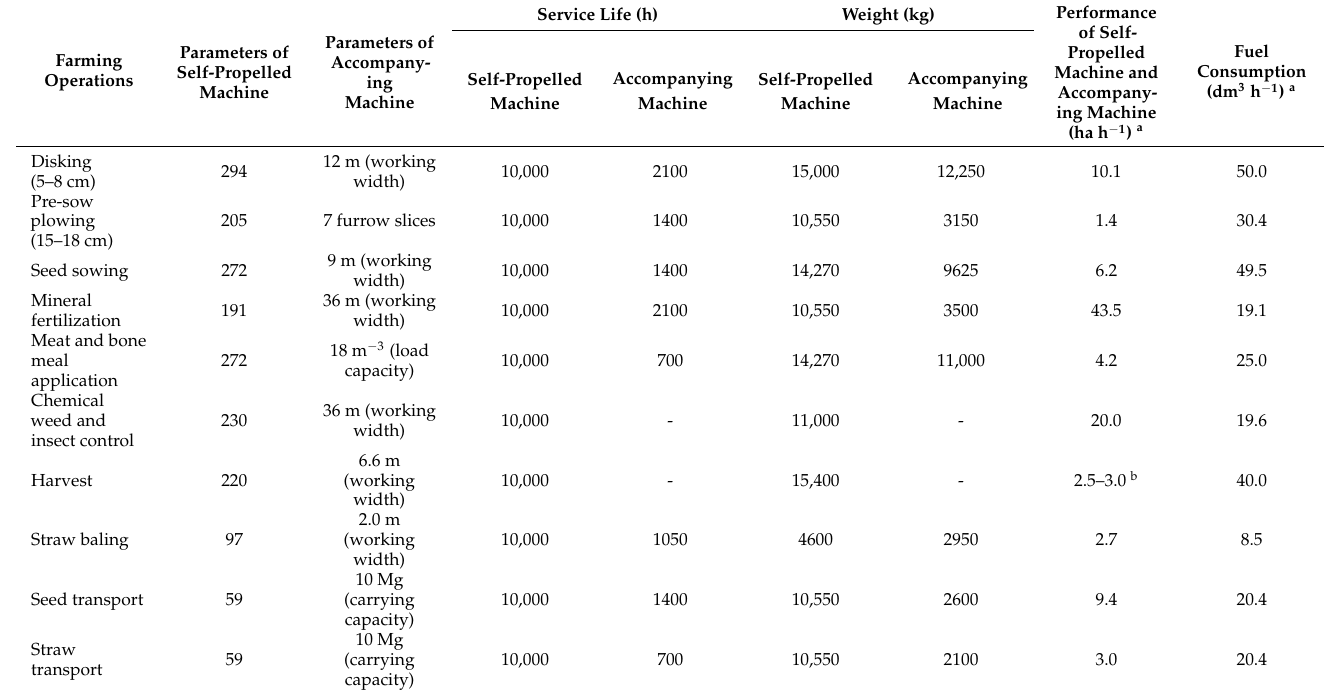
Table 2. Technical parameters, performance and fuel consumption of agricultural machines in the production of winter oilseed rape (across years).